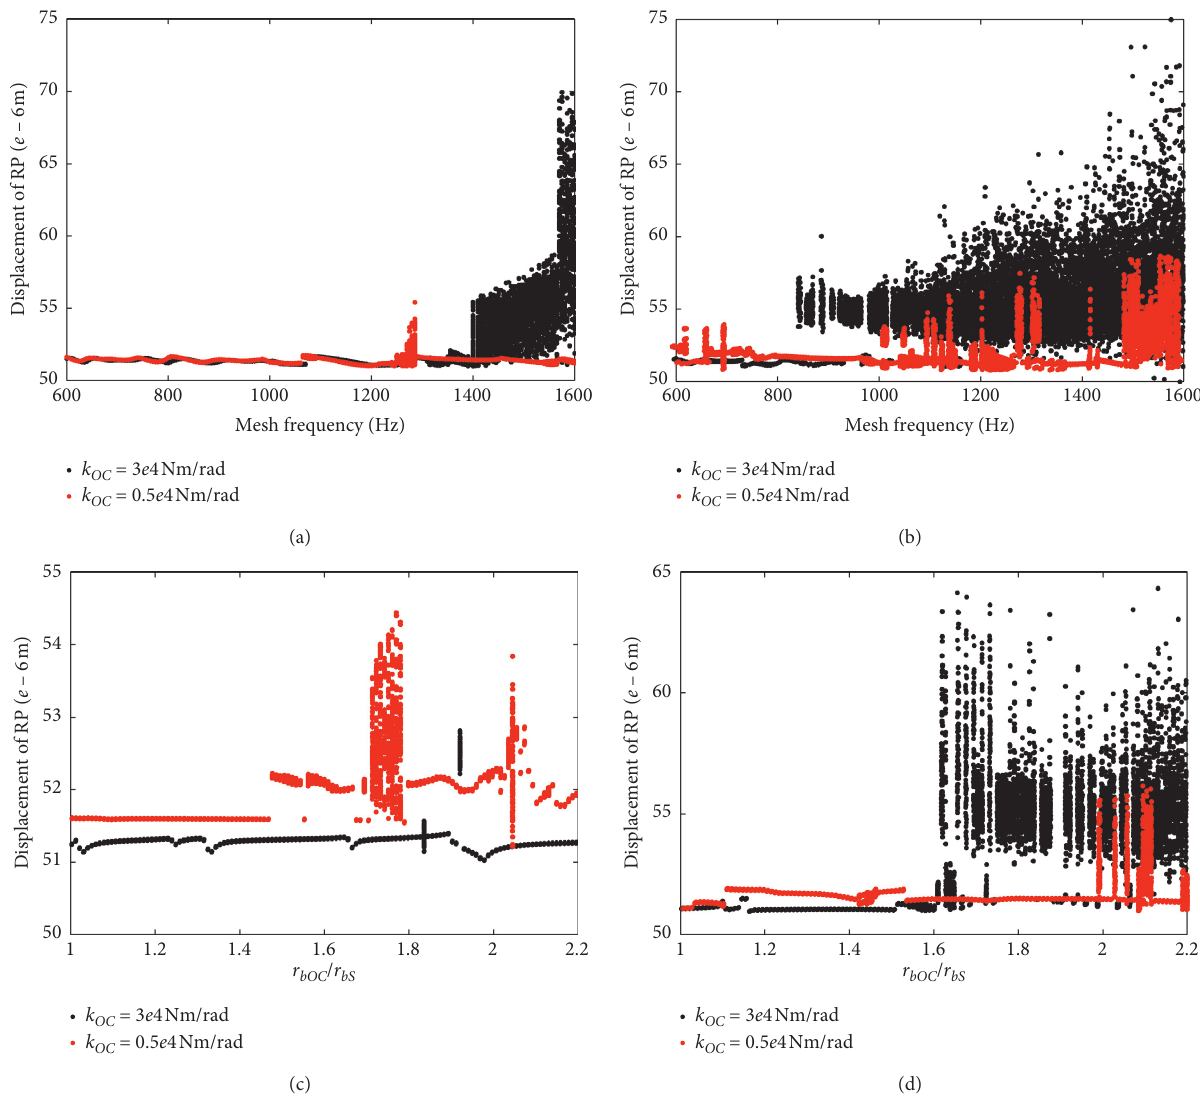
Figure 8: Stiffness and radius effects under Case B. (a) RP bifurcation diagrams when r and RP bifurcation diagrams with the changing radius at the mesh frequency (c) at 800Hz and (d) at 1200